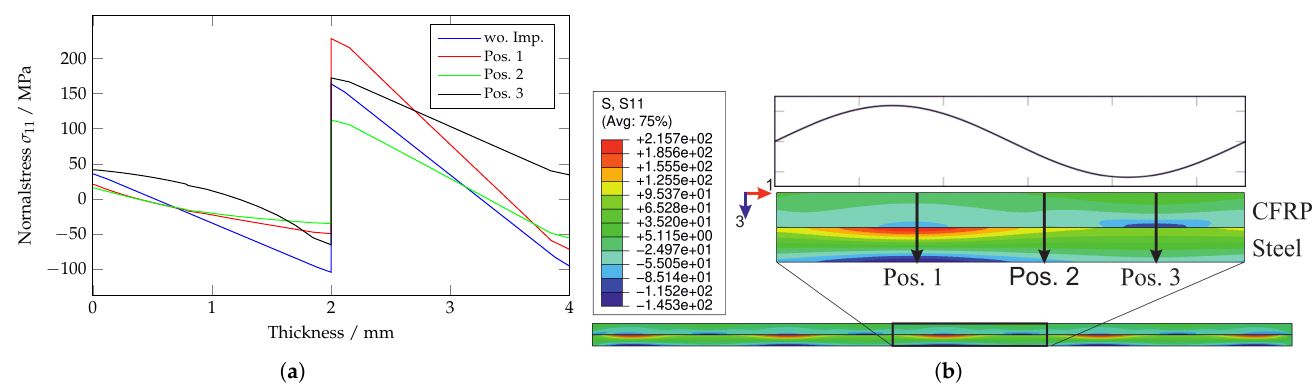
Figure 8. ( a ) Residual stress states with an out-of-plane fiber waviness (“Sinus D2”) compared to the reference residual stress state. The induced fiber waviness results in oscillating stress and strain fields in thickness direction along the x-axis. In addition, the waviness partially results in non-linear normal stress characteristics (see item 3). ( b ) shows the normal stresses σ 11 across the thickness. The corresponding fiber waviness is shown redon top of the enlarged contourplot.